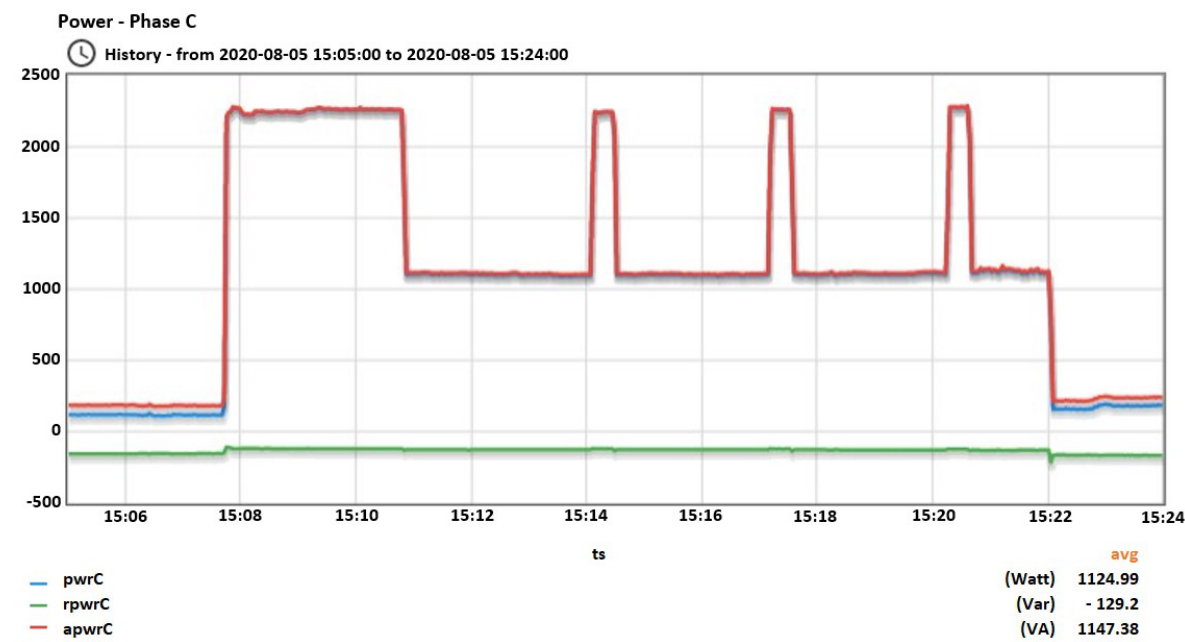
Figure 18. Press’ behavior. The ironing press operated in a time period where no other device changed the